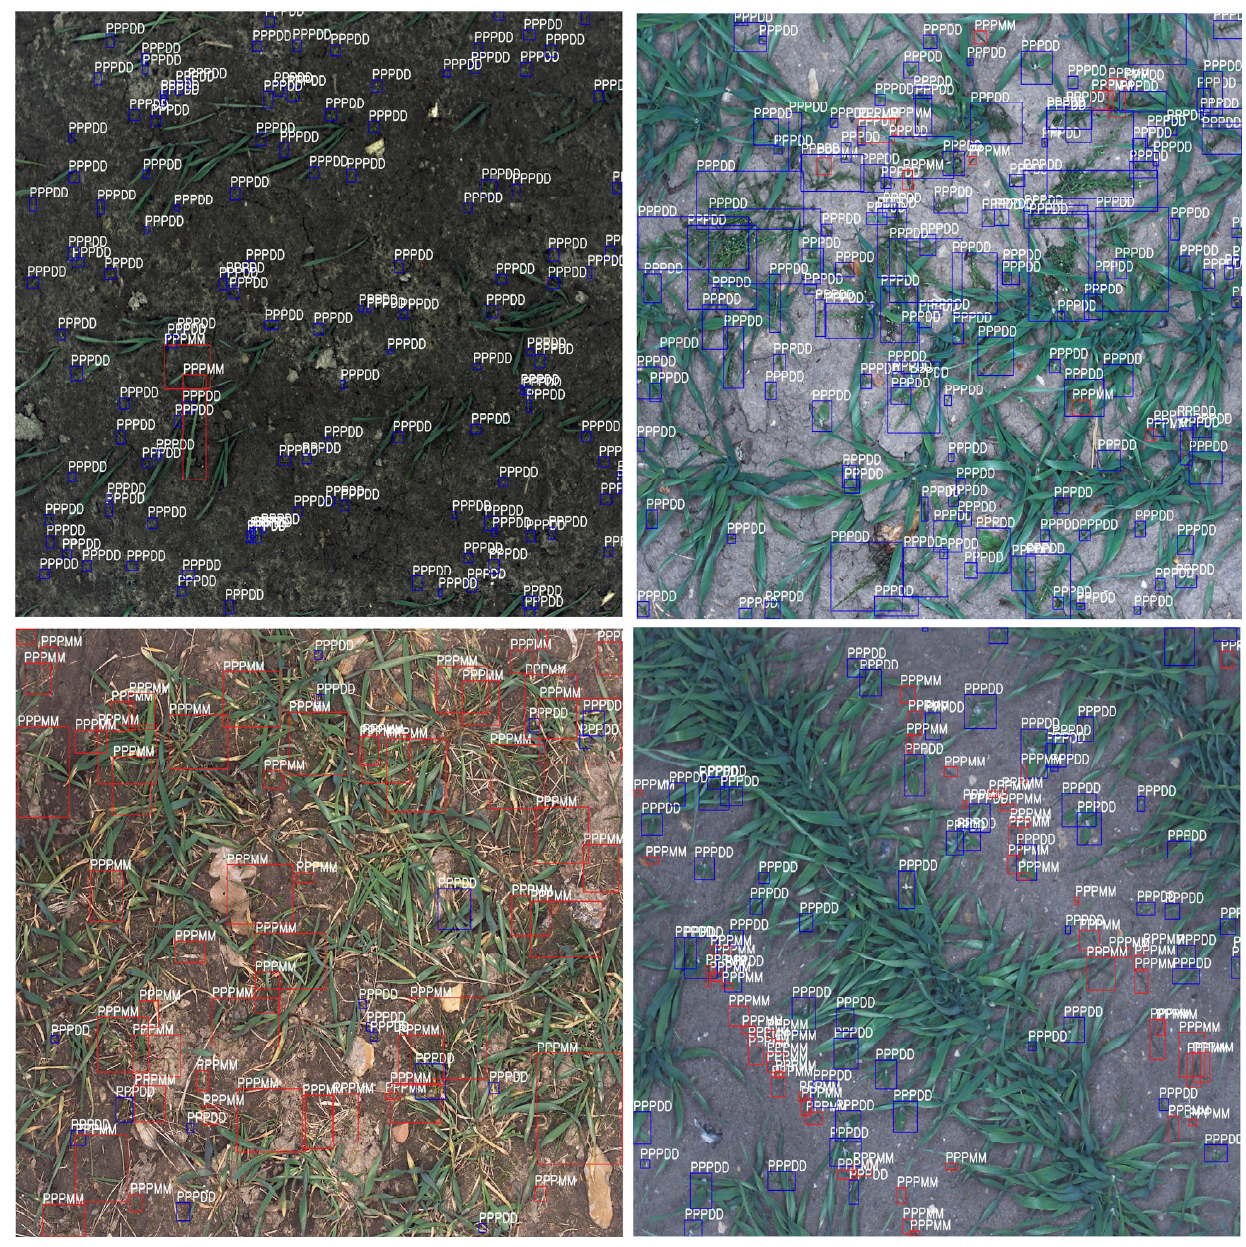
Figure 4. In Situ images with labels in various field environments with different illuminations.